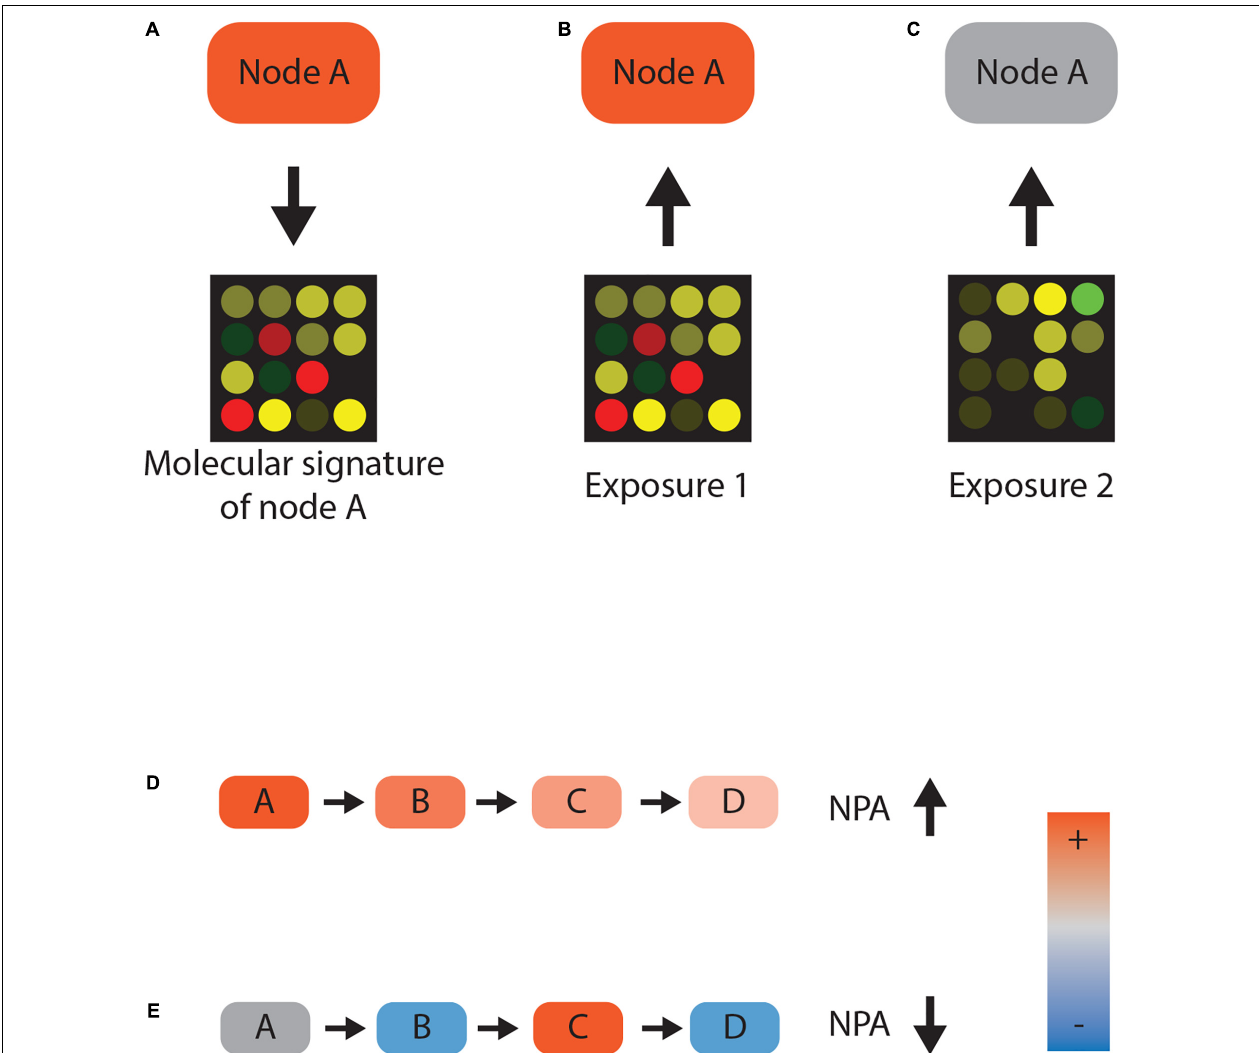
FIGURE 1 | Network scoring. (A–C) Reverse causal reasoning paradigm. Gene expression data following activation of protein A can be used as a molecular signature for the activity of that protein A. Any given transcriptomic dataset—for example, from chemically exposed samples—can now be used to infer the activity of protein A. Closely matching gene expression values indicate that protein A was active (B) , whereas disparate gene expression is not consistent with the activity (C) . (D,E) Network perturbation amplitude (NPA) calculation. If nodes A, B, and C positively regulate node D and their activities are inferred to be high, there is a high consistency between gene expression and network topology. High consistency leads to a high NPA value (D) . Conversely, if node activity and the topology of the network contradict each other, the NPA value decreases (E)